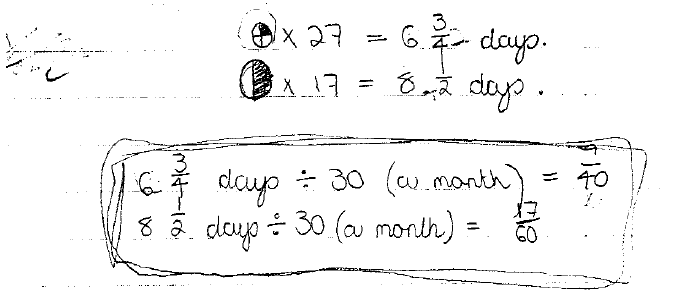
Figure 3: Part A of Liya’s solution to the cat pills problem